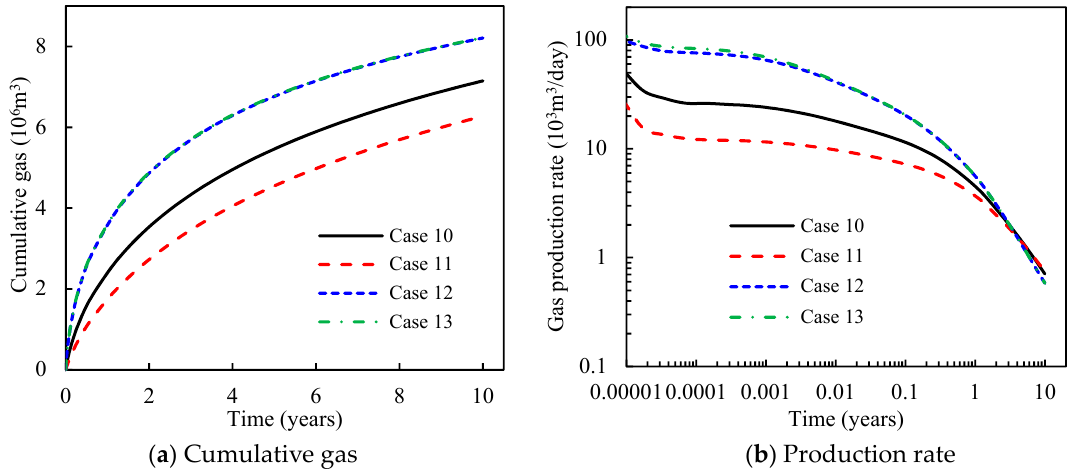
Figure 26. Comparisons of cumulative gas and production rate obtained from different cases.